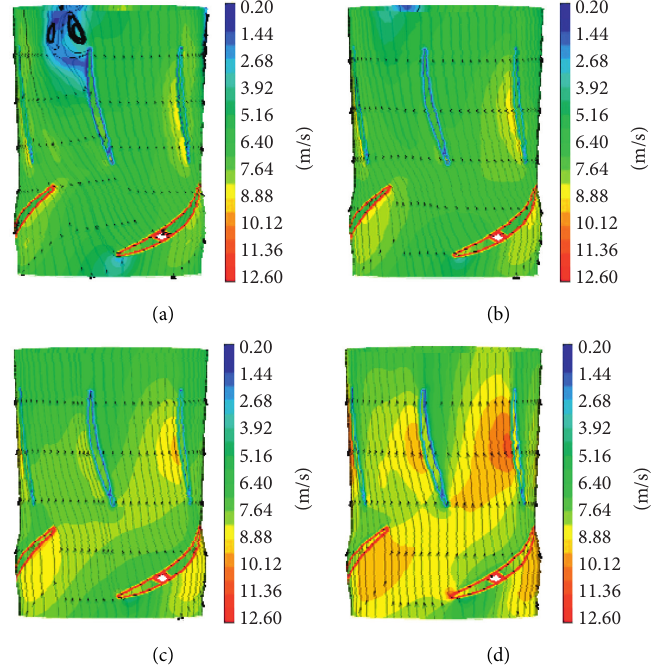
Figure 11: Flow fields in the pump segment under different conditions of discharge rates ( Δ β �− 10 ° , h � 0 . 25 H ). (a) Q � 0.30 m 3 /s, (b) Q � 0.35 m 3 /s, (c) Q � 0.40 m 3 /s, and (d) Q � 0.45 m 3